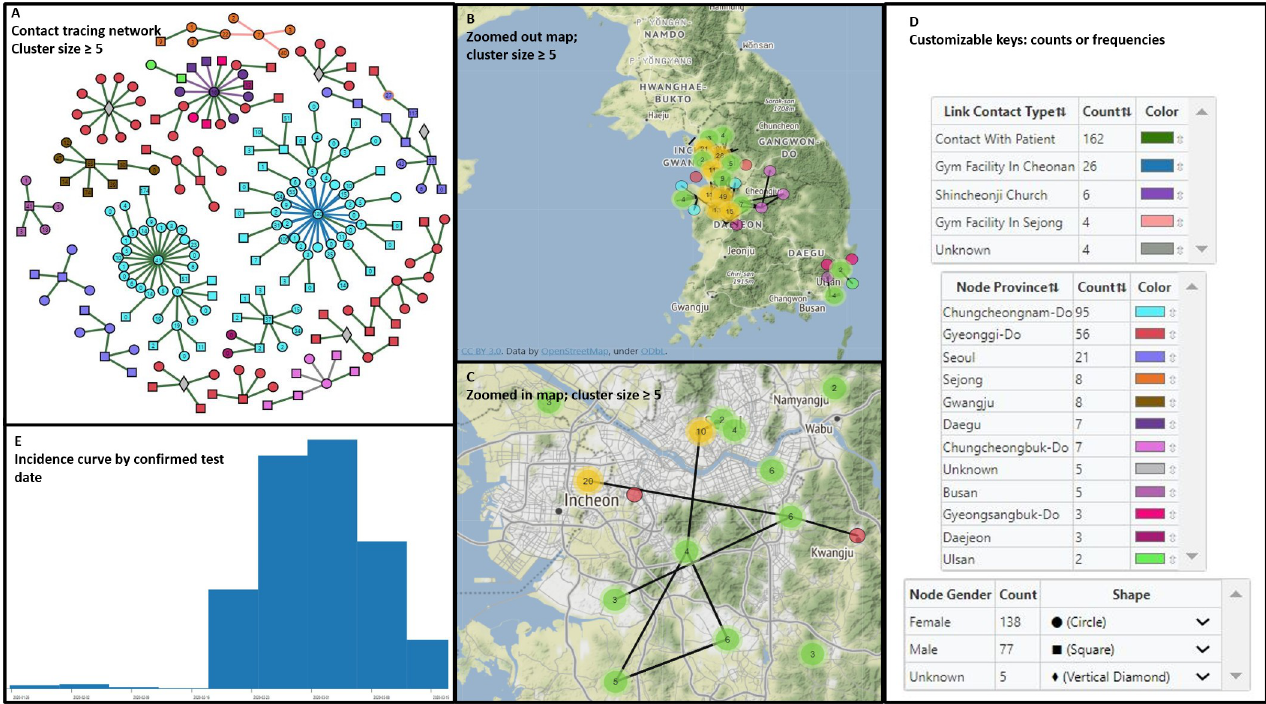
Fig 3. MicrobeTrace allows the creation of informative dashboard visualizations by tiling of different views within the browser window. (3A) Reports of high-risk contact between COVID-19 cases in clusters of size N � 5, nodes are (i) colored by province, (ii) shaped by gender, and (iii) labeled with the total number of high-risk contacts. (3B) Geospatial map of clusters of size N � 5 zoomed to show only Seoul, South Korea. (3C) Geospatial map of clusters of size N � 2. Node positions have been randomly altered with the ‘jitter’ functionality to preserve patient privacy. (3D) In-application color and shape keys that offer interactive color-pickers and labeling. (3E) Incidence curve showing confirmed test date. Map tiles provided by http://stamen.com/ under CC BY 3.0; data by openstreetmaps.org